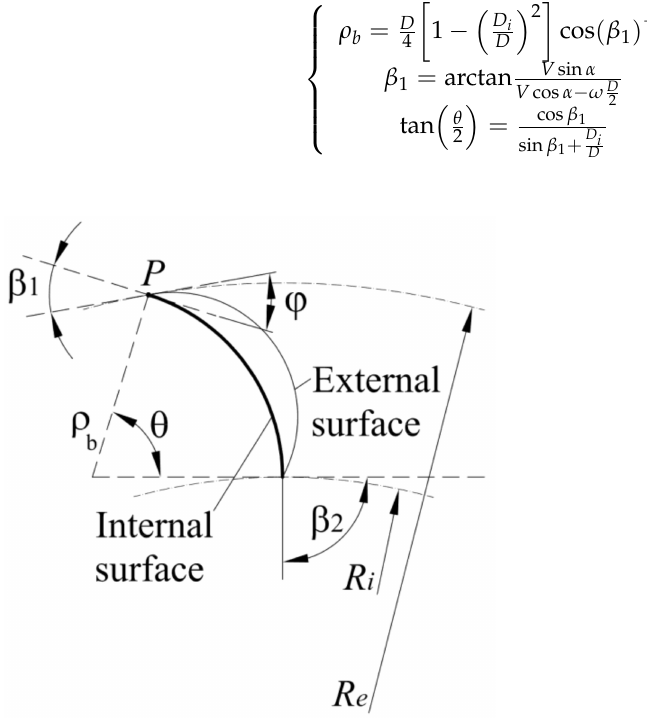
Figure 5. Blade internal and external